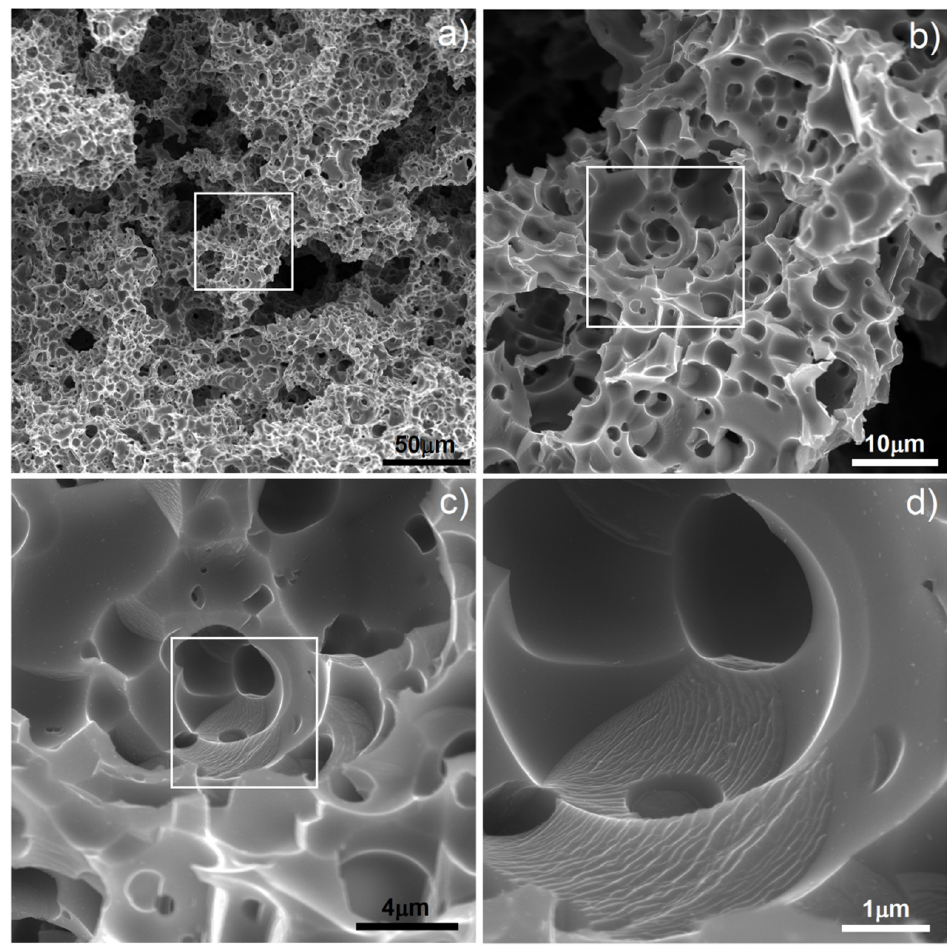
Figure 6. SEM micrographs of the Ti20Nb5Zr foam after electrochemical etching: ( a – d ) various magnifications.